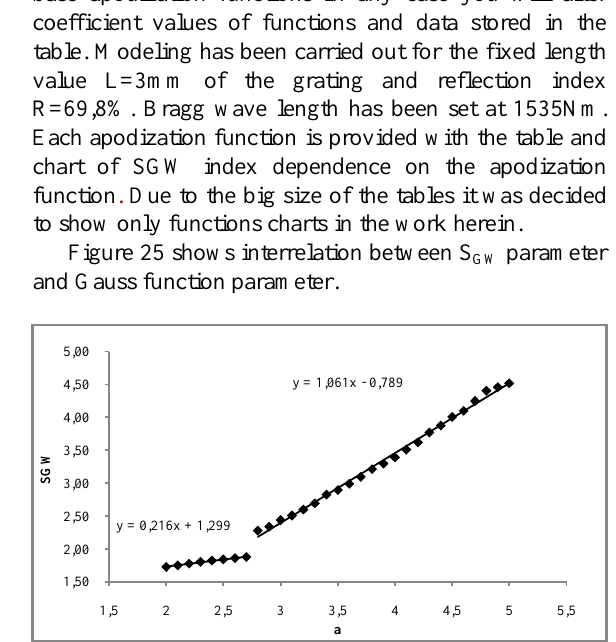
Fig. 25. Chart of the parameter S GW and Gauss function parameter.